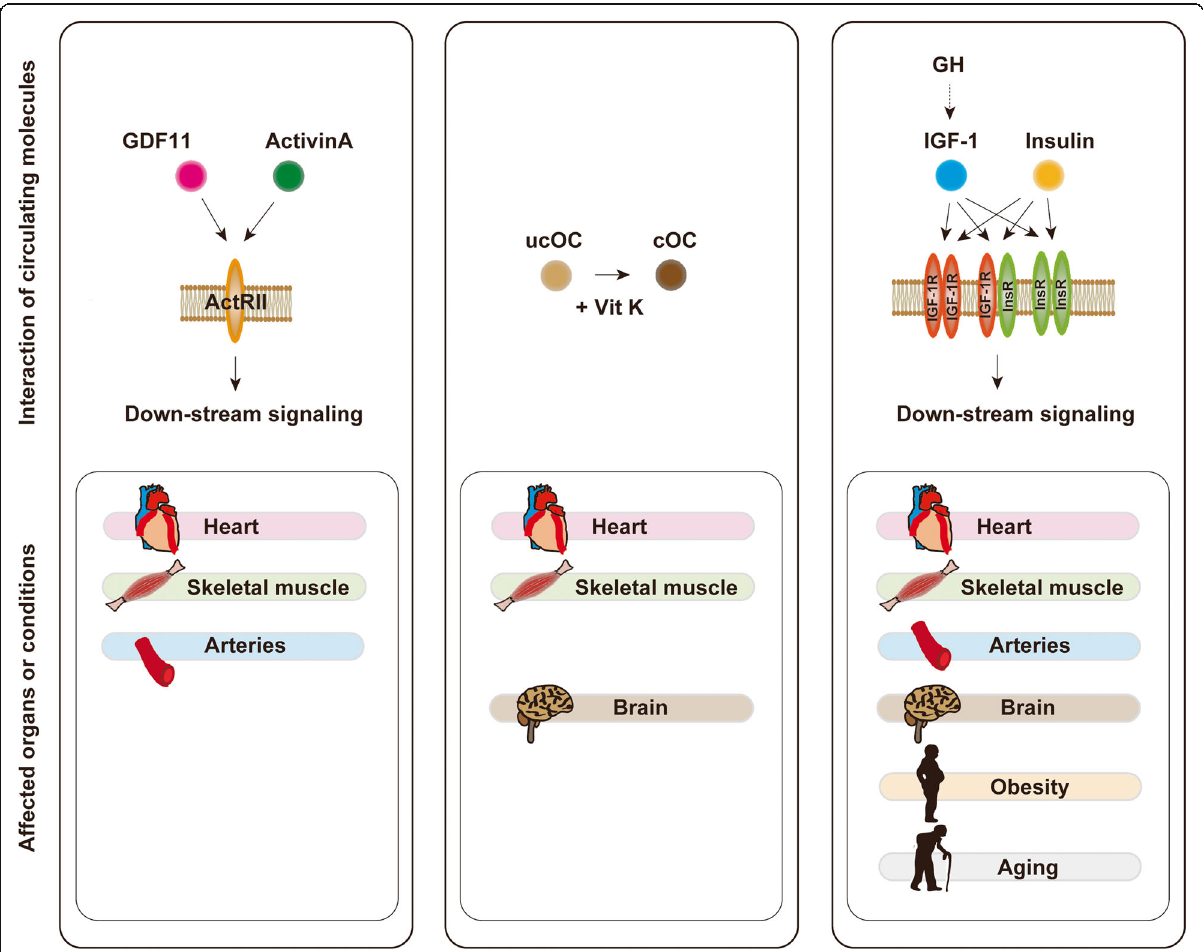
Fig. 3 Interaction of circulating molecules described in this review article. Growth differentiation factor (GDF) 11 and activin A binds with activin type II receptor (ActRII). Vitamin K acts as a coenzyme of carboxylase and enhances the carboxylation of undercarboxylated osteocalcin (ucOC) to carboxylated osteocalcin (cOC). Growth hormone (GH) secreted from the pituitary gland increases the production of insulin-like growth factor-1 (IGF-1). Insulin and IGF-1 bind with IGF-1 receptor and/or insulin receptor (InsR). These affect organs or conditions as described in the